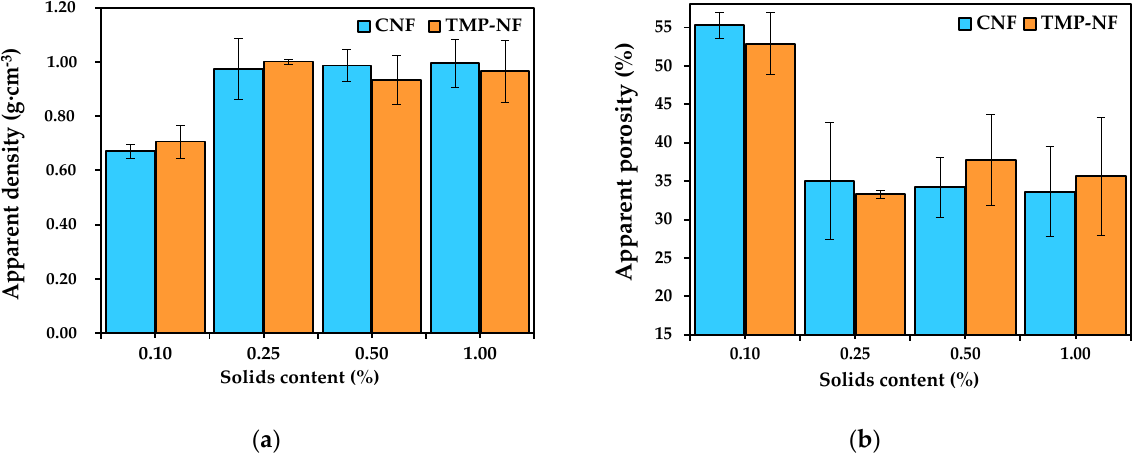
Figure 11. Structural properties of the developed films. ( a ) Apparent density; ( b ) Apparent porosity. Note: Values are presented as means ± SD. N = 6. Values followed by common letters in the super index indicate estimated significant differences between each pair of means media ( p > 0.05).